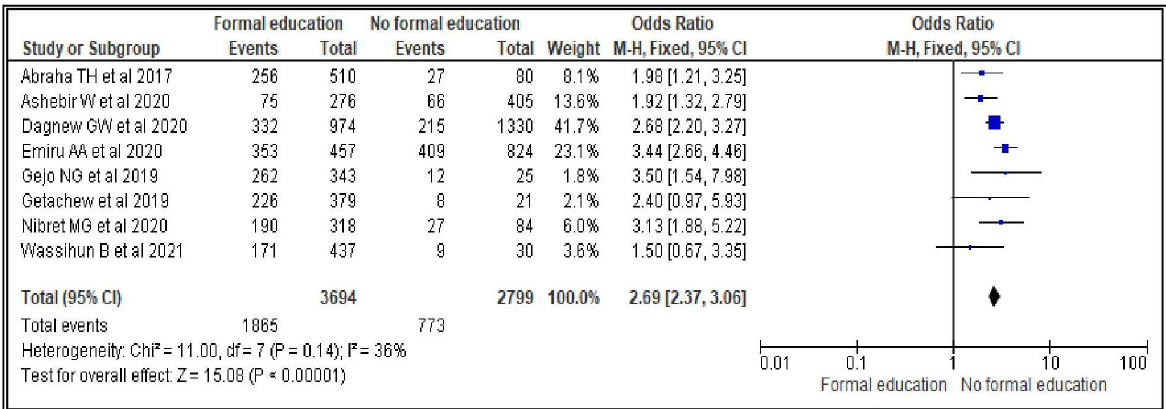
Fig 2. Association between women’s educational status and modern contraceptive uptake during postpartum period, 2021.